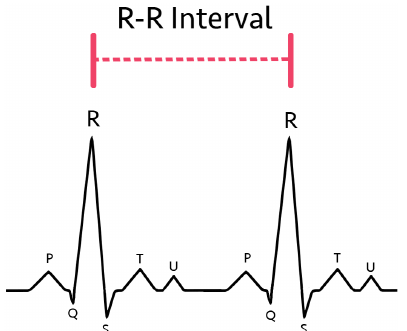
Figure 1. R-R interval diagram in the classical EKG